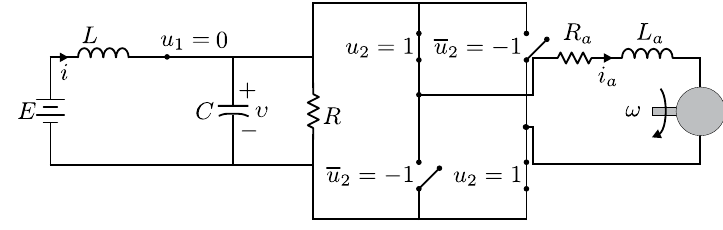
Figure 3. Equivalent circuit when u 1 = 0 and u 2 =